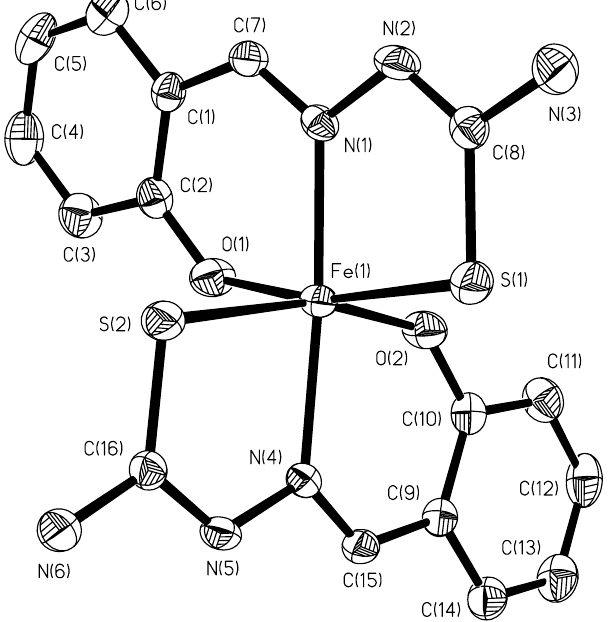
two-dimensional structure, the molecules are connected to each other through intramolecular and intermolecular hydrogen bonds with d (N5···O3) = 2.832 Å and (cid:2) N5–H5···O3 = 152.1°,